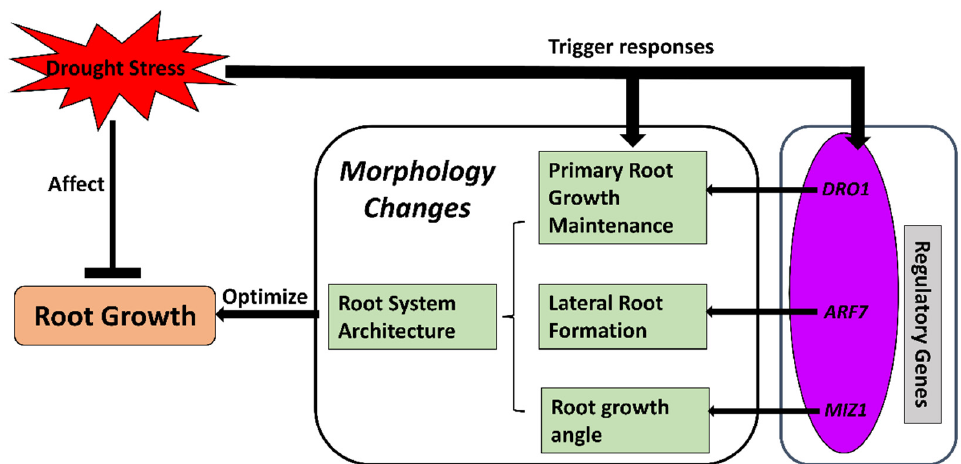
Figure 2. Morphological changes occurring in crop roots under drought stress. Drought stress prevents root growth while triggering regulatory mechanisms to change root morphology. Regulatory genes are activated to modify the root traits for better root structure architecture (RSA) under drought stress. Optimized RSA could maintain or promote root growth under such conditions. ARF7 , AUXIN RESPONSE FACTOR 7 gene; DRO1 , DEEPER ROOTING 1 gene; MIZ1 , MIZU KUSSEI 1 gene.